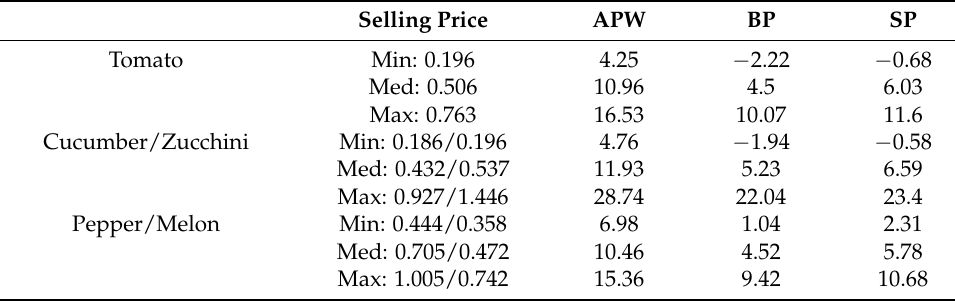
Table 7. Apparent Productivity and Shutdown and Breakeven